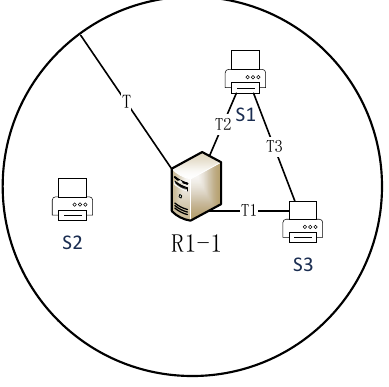
Figure 3. Deterministic latency characteristics in enhanced resolution